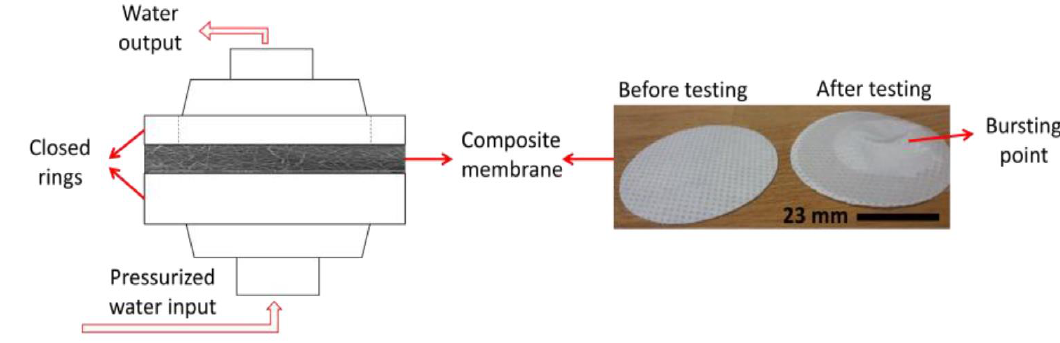
Figure 5. Bursting strength testing unit.